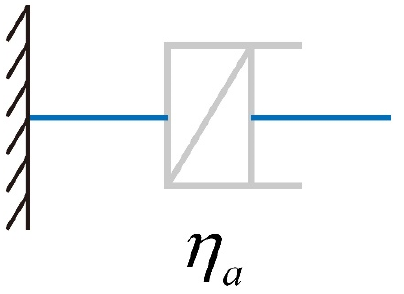
Figure 7. Abel fractional element.